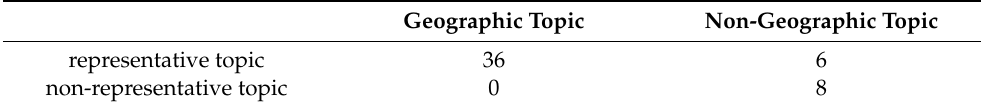
Table 15. Topic segmentation based on results in Sections 5.2.1 and